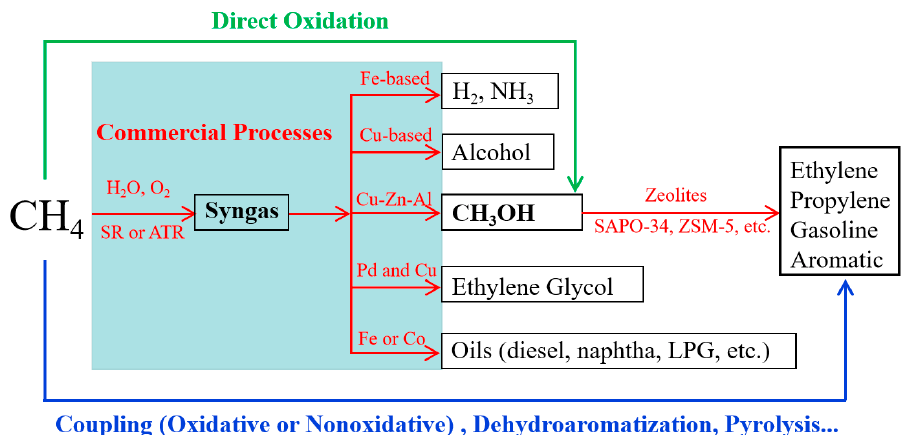
Figure 1. Significant pathways for value-added utilization of CH 4 . Commercial (indirect) pathways through syngas are indicated in red. Direct routes to olefins, gasoline or aromatics, by various processes, are in blue, while the direct oxidation to CH 3 OH is in green.